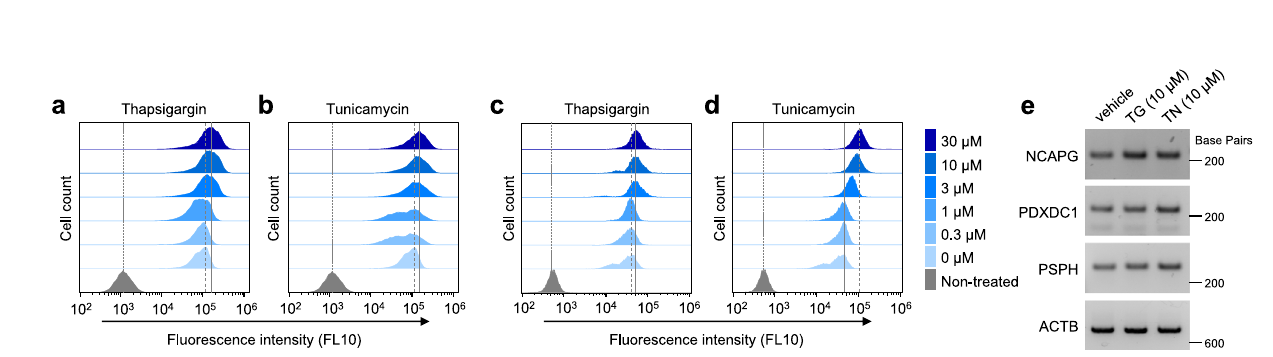
Fig. 7 | ER stress responses. Flow cytometry analysis of a , b EliF-1b (10 μ M), and c , d EliF-2c (10 μ M) in ER stress-induced HeLa cells. ER stress was chemically induced by increasing concentrations (0 – 30 μ M) of either thapsigargin (TG; for a and c )ortunicamycin(TN;for b and d )preincubationfor 12h, and monitored by cell population shifts in fl ow cytometry using FL10 fi lter ( λ exc =405nm; λ em =550/